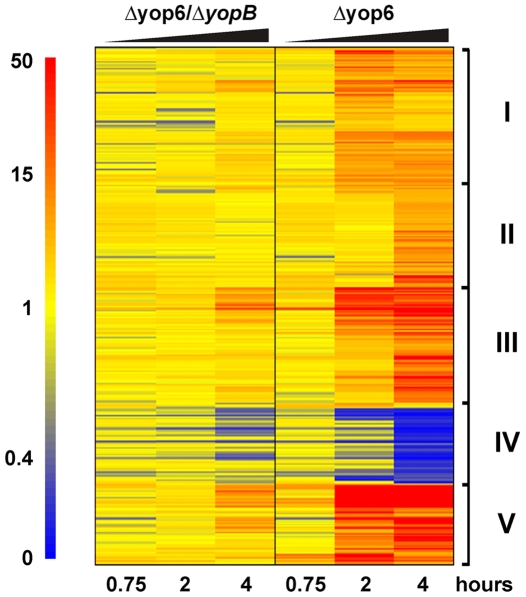

Y. pseudotuberculosis expressing a functional T3SS translocator induces robust macrophage gene expression.MyD88−/−/Trif−/− macrophages were infected with Y. pseudotuberculosis Δyop6, Δ6/ΔyopB, or were left uninfected. Total RNA was isolated and Affymetrix GeneChip Mouse Genome 430 2.0 arrays were used to probe the relative gene expression profiles for each experimental condition. The expression of 266 murine genes (represented by 340 probe sets) was regulated by Y. pseudotuberculosis Δyop6 at least four-fold (p<0.05) more than by Y. pseudotuberculosis Δ6/ΔyopB during at least one time point. The probe sets were clustered into a heat map according to the Pearson correlation. From left to right, the 45 minute, two hour, and four hour time points are shown for each bacterial strain. The colorbar ranges from zero to 50-fold change in gene expression compared to the uninfected condition where red represents upregulated genes, yellow represents no change from uninfected, and blue represents downregulated genes.